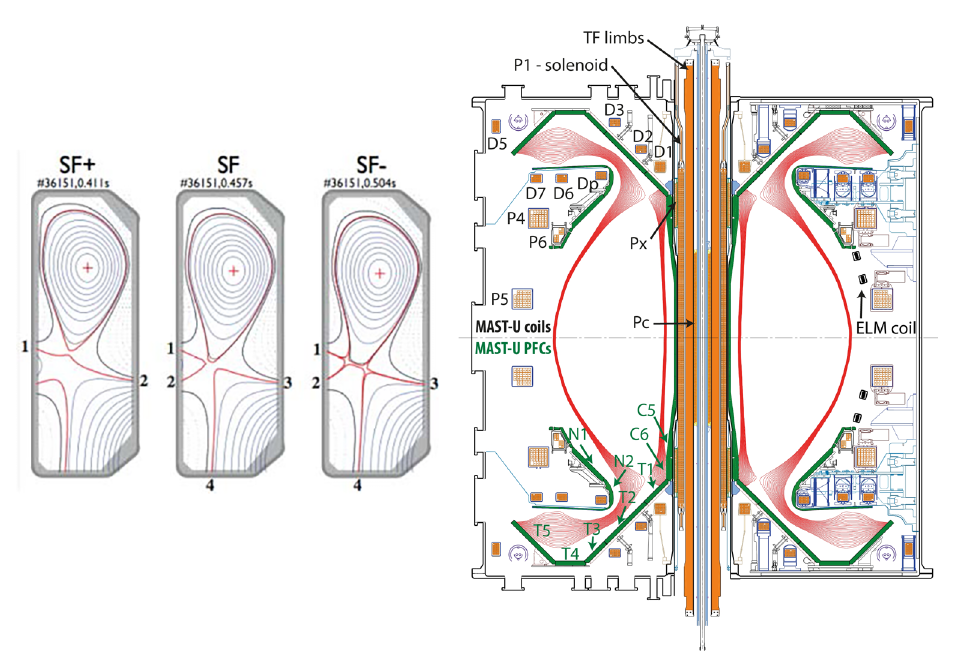
Fig. 5. – (a) Snowflake divertor configuration tested on the TCV tokamak (from ref. [16]). (b) Super-X configuration to be tested on the MAST-U tokamak (from ref.